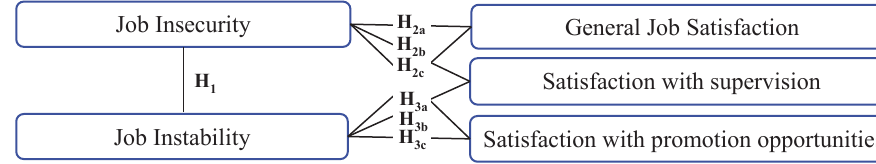
Fig. 1 – The influence of job insecurity and instability on job satisfaction. Source: own